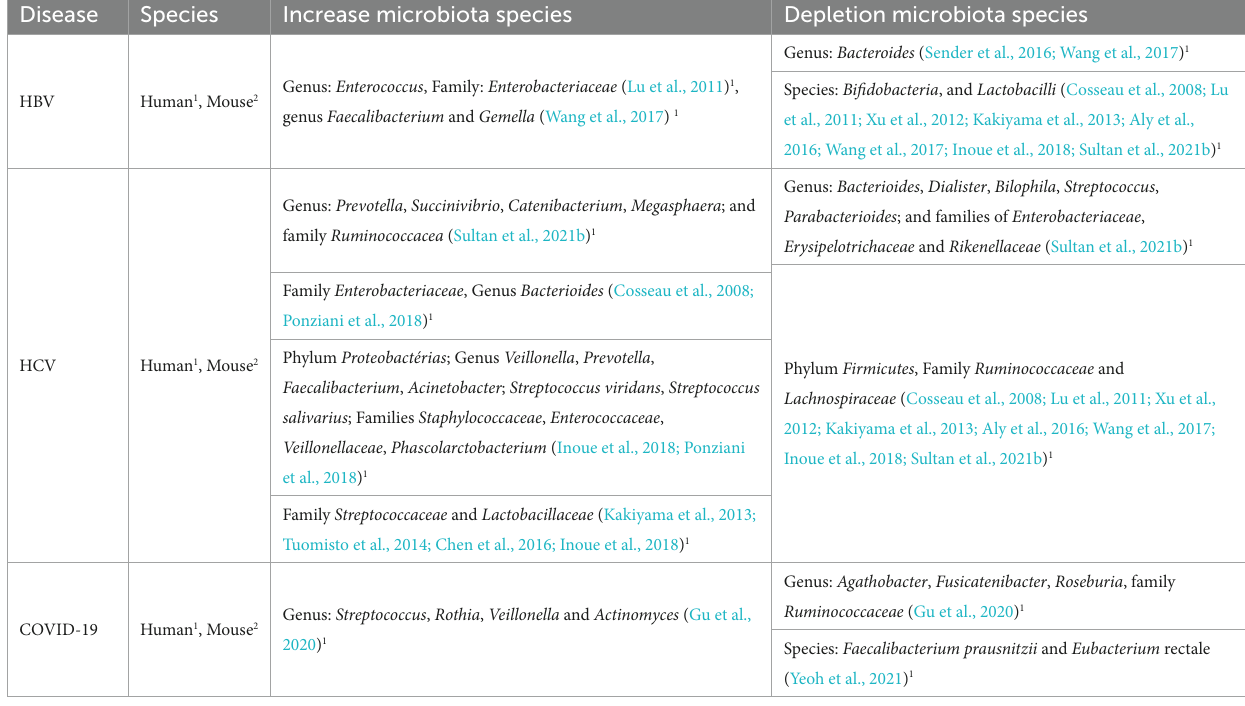
TABLE 2 Viral diseases and alteration of the gut microbiota composition.